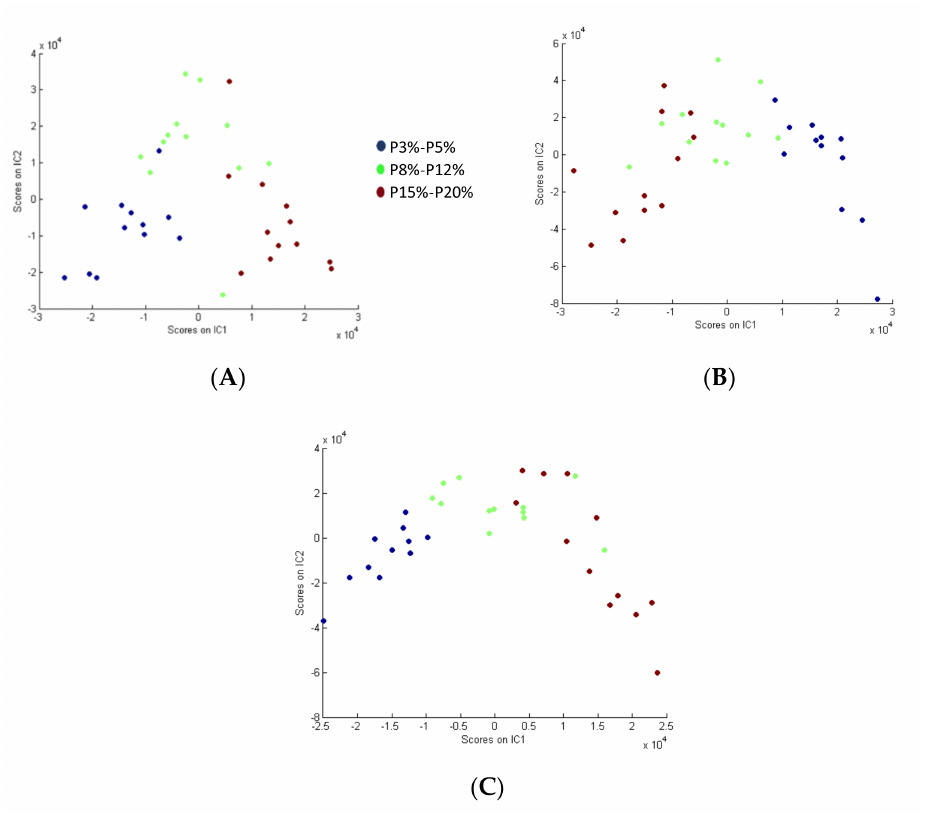
Figure 3. Independent components-discriminate analysis proportions plot calculated after source signal extraction for Table 1. IC2 in urine ( A ), portal vein ( B ), and vena cava ( C ). For urine samples, the ICDA method revealed that fifty-four features were associ- ated with the consumed diets. After an ANOVA test, a total of thirty-five variables were considered statistically different between groups (Table 2 and Figure S2). Among these variables, sixteen metabolites, namely, 4-pyridoxate, anthranilate, cadaverine, homogen- tisic acid, indoxyl sulfate, isovaleoylglycine, kynurenic acid, L -gulonolactone, L -leucine, n -acetylputrescine, n -methyl-2-pyridone-5-carboxamide, pipecolate, putrescine, spermi- dine, uracil, and xanthurenate, were up-regulated when the percentage of protein